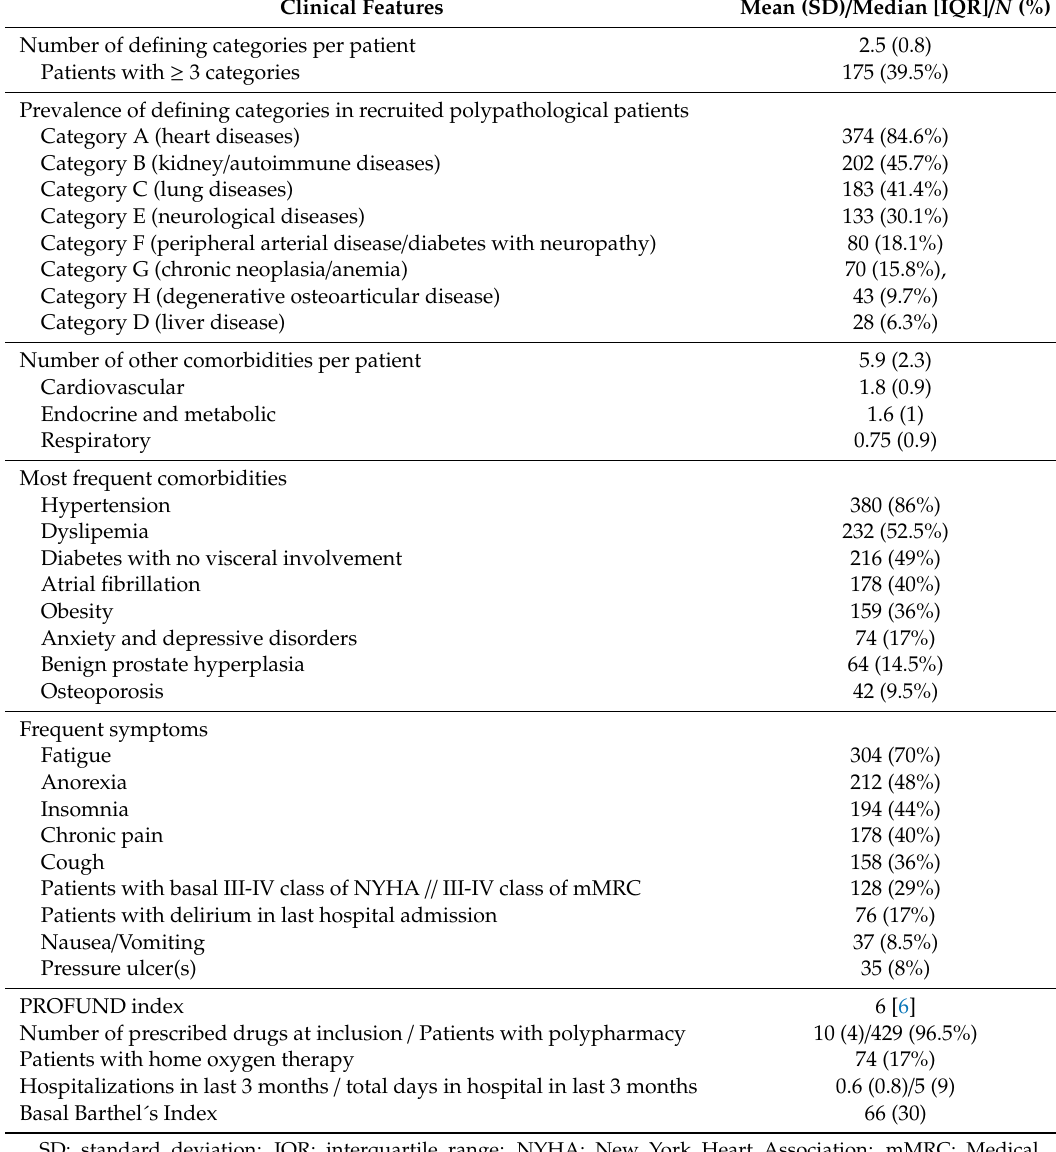
Table 2. Main clinical features of a multicenter sample of 444 polypathological patients recruited for sarcopenia and frailty